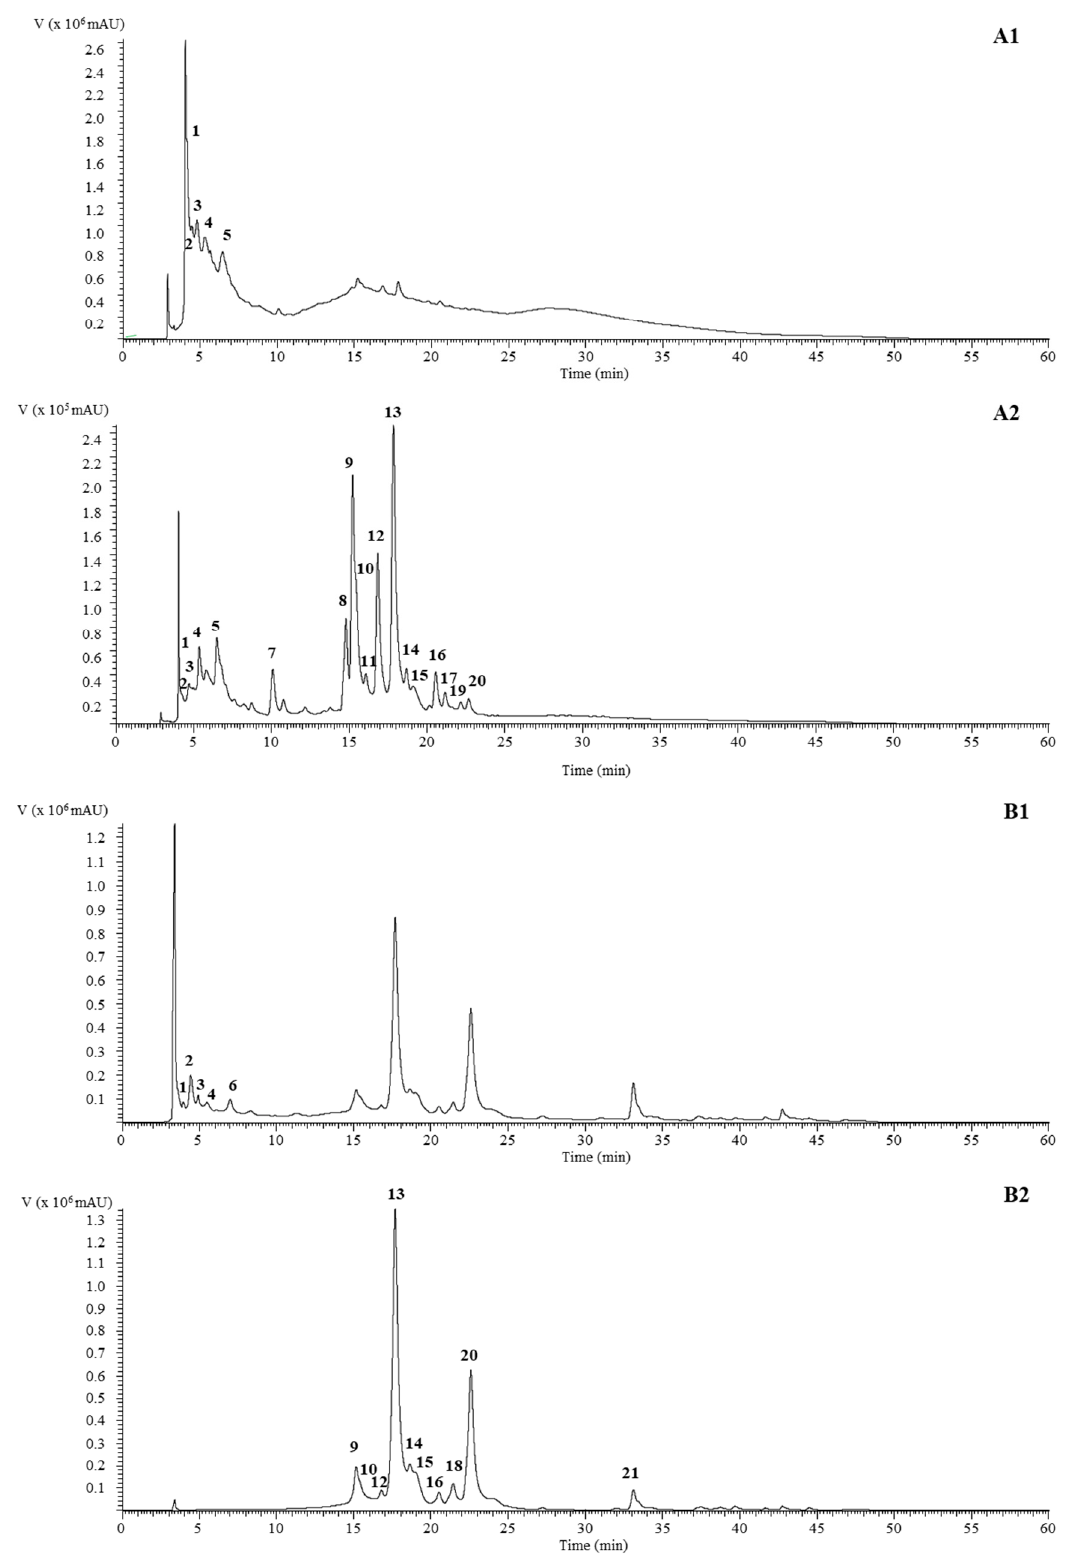
Figure 1. Phenolic profile of aqueous and ethyl acetate extract of C. villosus recorded at 280 nm ( A1 and B1 , respectively) and 370 nm ( A2 and B2 , respectively).